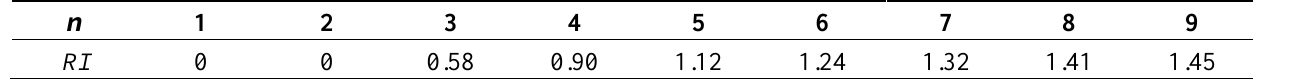
Table 9. Values of the mean random consistency index ( RI ).